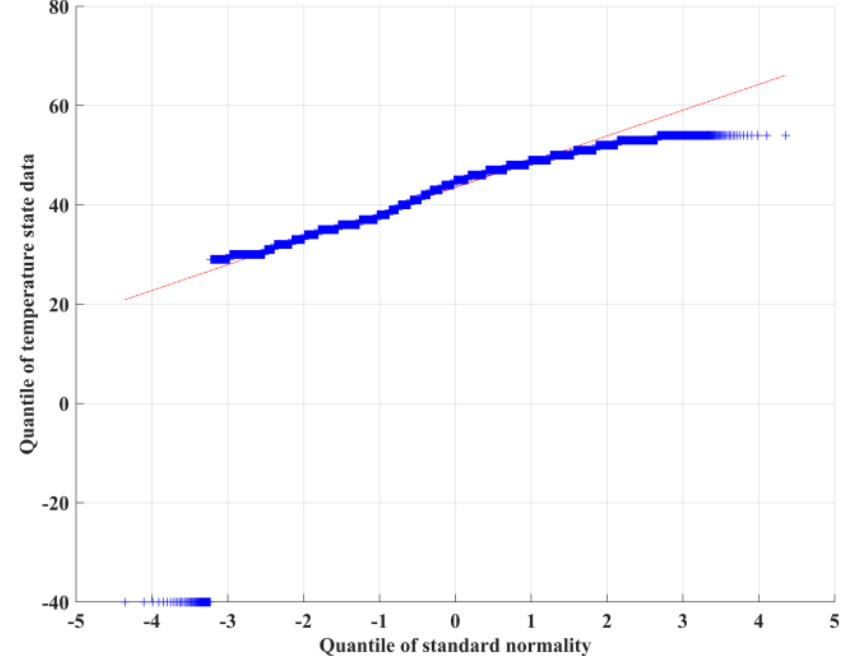
Figure 4. Q − Q diagram of temperature data.